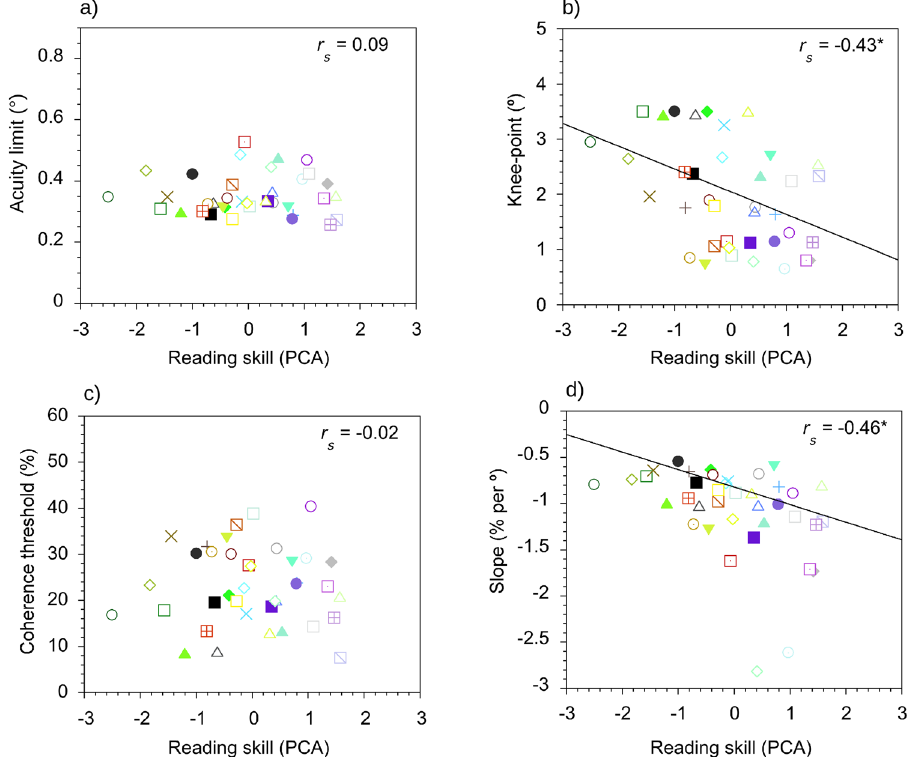
Figure 3. Scatter plots for the motion task in the entire sample of readers ( N = 38) showing the relationships between reading ability and acuity limits ( a ), the knee-point of the curves ( b ), coherence thresholds at asymptote ( c ) and the slope of the descending limb ( d ). Each coloured symbol represents an